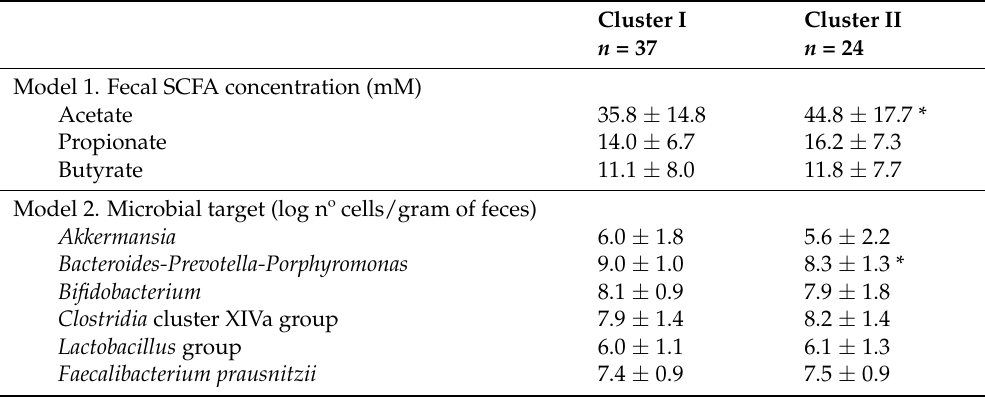
Table 5. Differences in fecal SCFA and major microbial groups between